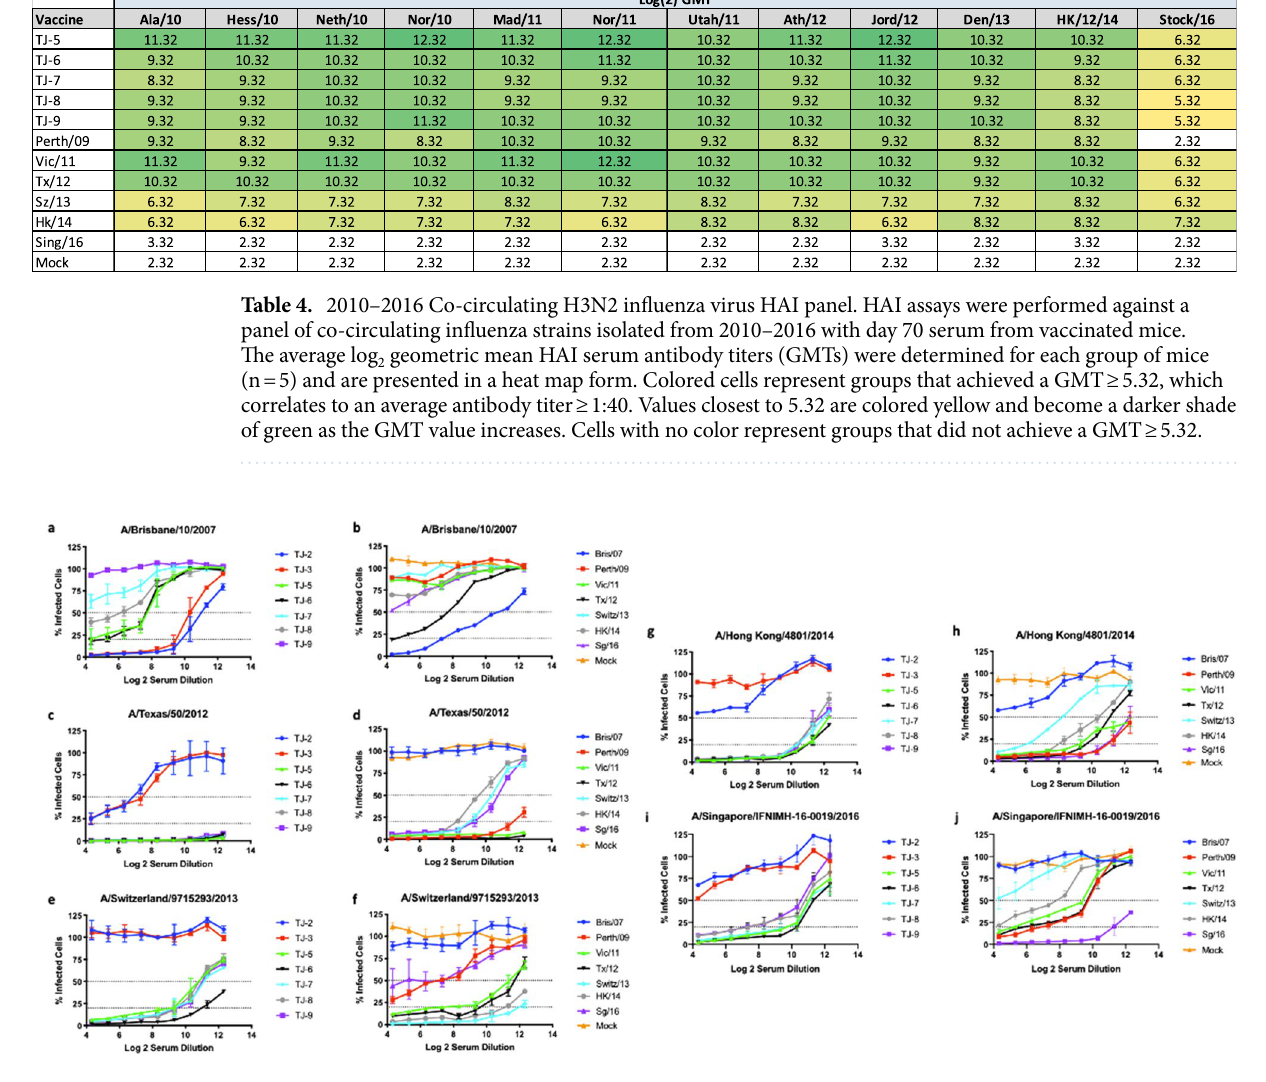
Figure 3. H3N2 focal reduction assay. FRA neutralizing antibody titers were determined using pooled sera for each group of naïve mice vaccinated 3 times with one of 7 next-generation COBRA H3 HA antigens (TJ-2, TJ-3, or TJ5–9) or H3 VLP vaccines expressing wild-type HA proteins (Bris/07, Perth/09, Vic/11, Tx/12, Switz/13, HK/14, or Sing/16) from historical influenza virus isolates at day 70. ( a , b ) Average Log 2 neutralizing antibody titers against the A/Brisbane/10/2007 H3N2 virus. ( c , d ) Average Log 2 neutralizing antibody titers against the A/Texas/50/2012 H3N2 virus. ( e , f ) Average Log 2 neutralizing antibody titers against the A/Switzerland/9715293/2013 H3N2 virus. ( g , h ) Average Log 2 neutralizing antibody titers against the A/ Hong Kong/4801/2014 H3N2 virus. ( i , j ) Average Log 2 neutralizing antibody titers against the A/Singapore/ IFNIMH-16-2016 H3N2 virus. For each virus, the virus concentration was standardized to 1.2 × 10 4 FFU/mL. The dotted lines represent the 50% and 80% inhibition of viral infection by antisera compared to virus only control